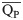
Block diagram of the control system.CVS, cardiovascular system; VAD, ventricular assist device, LVAD, left VAD; u, mean pulse-width modulation drive signal to the LVAD; HCVS, differential pressure between the left ventricle and the aorta; CLn, Control line; S1, original state; S2 and S3, deviated states; QP, pump flow; QP¯, mean pump flow; QPRef¯, The reference (desired) mean pump flow; PLVEDm, mean left ventricular end diastolic pressure; ω, pump speed; ω¯, mean pump speed; ω¯SP, mean pump speed set-point; Grey circles, position of operating points after changes in states; Black circles, position of operating points upon arriving at the new steady state located at the intersection between the control line and the new system line. The controller drives the changes in the operating points along the path indicated by the arrows along the new system line; PLVEDm serves as the input to the preload controller (Eq 1); ∑, 1-second moving average filter.